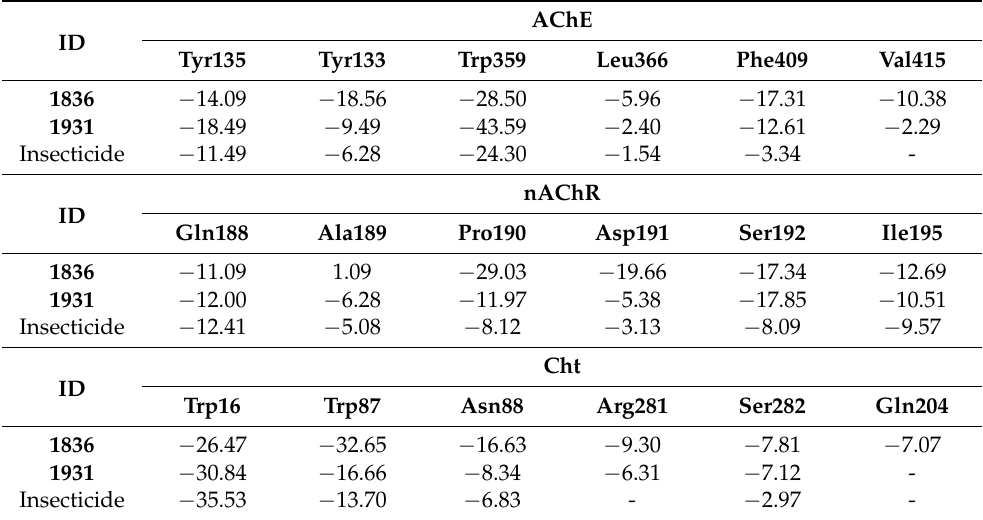
Table 10. Summaries of the interaction values of the main amino acids for A. gossipy .